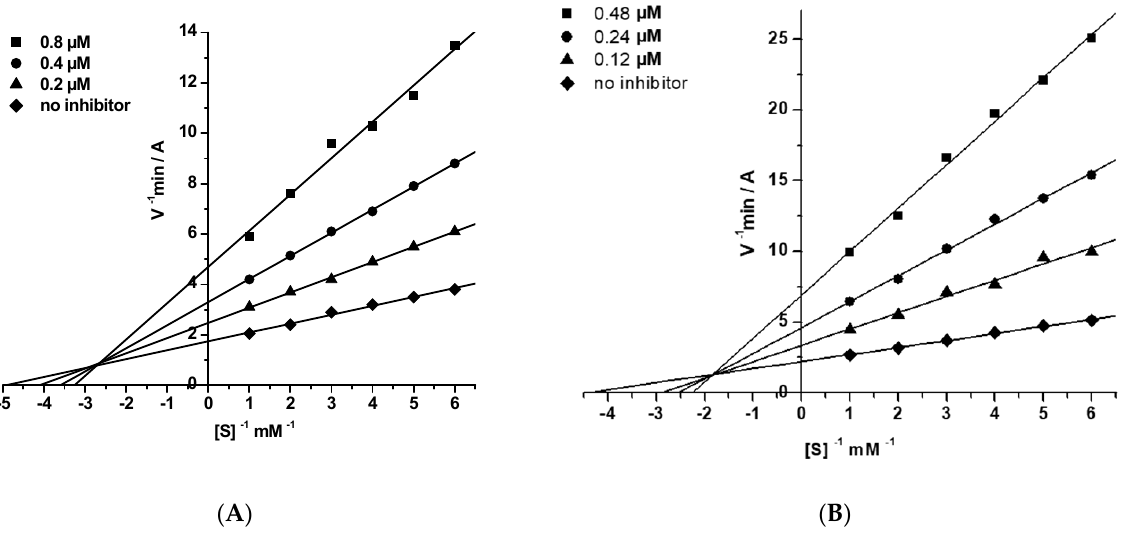
Figure 3. Steady state inhibition of ( A ) AChE and ( B ) BChE by compound 6b . Lineweaver–Burk double-reciprocal plots of initial velocity and substrate concentrations in the presence of inhibitor (three concentrations) and without inhibitor are presented. The changes in both K m and V max attest to a mixed type of inhibition.